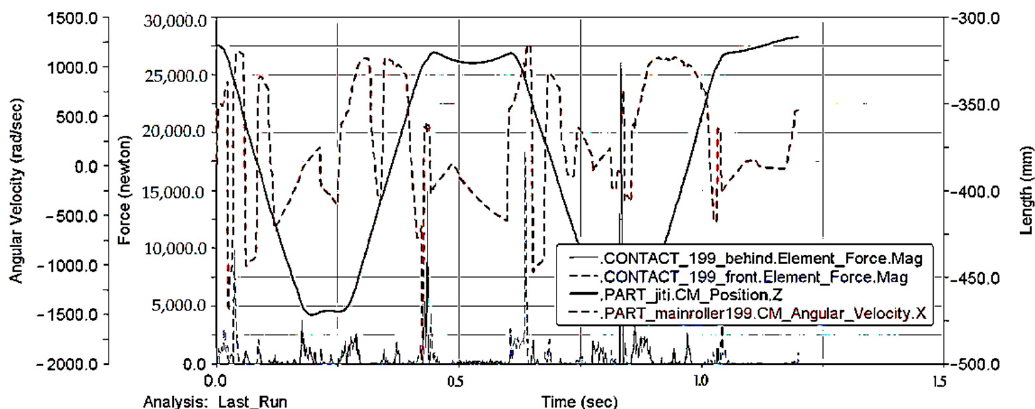
Figure 17. The bolt body motion without recoil and with a 0.1 mm gap.